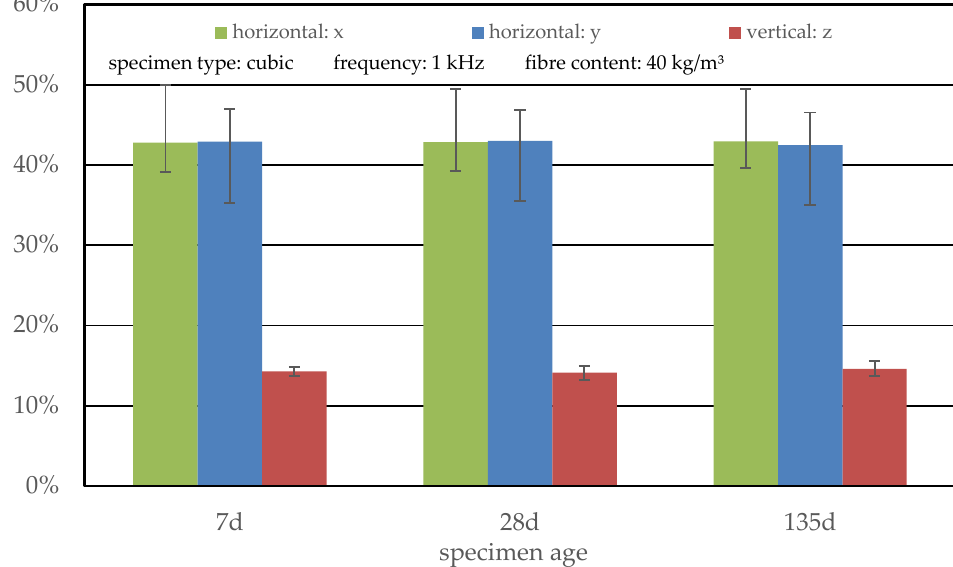
Figure 8. Calculated fibre orientation of the cubic specimens with a fibre content of 40 kg/m 3 , based on the electrical resistivity measurements on specimens with different concrete ages at a frequency of the alternating current of 1